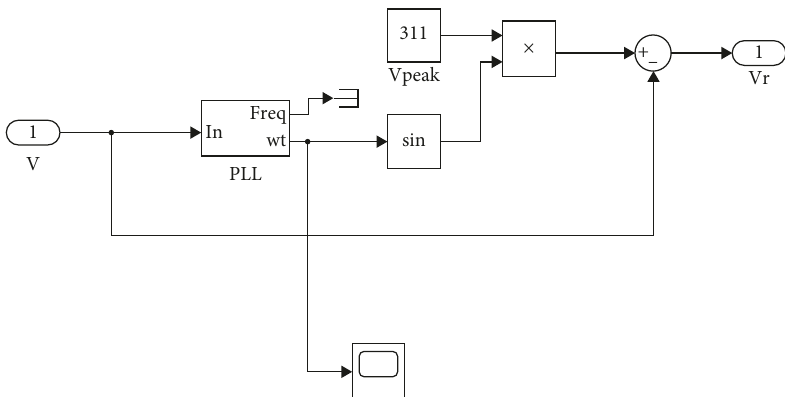
Figure 11: Structure of reference voltage calculation unit by using the traditional voltage compensation